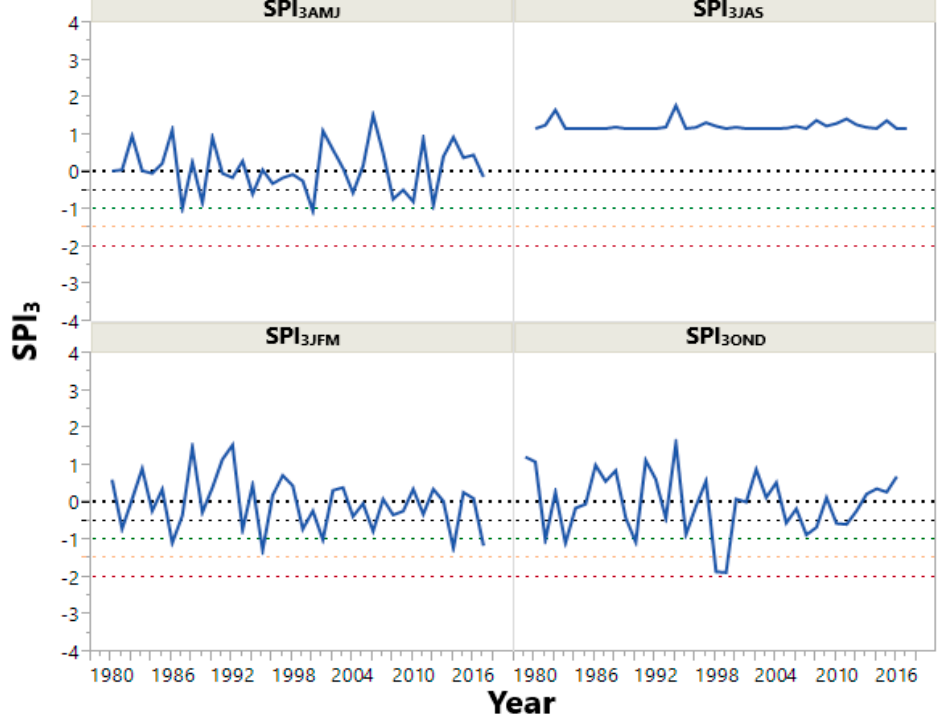
Figure 8. Overall trend of the standardized precipitation index of quarter periods (SPI 3 ) values from 1980 to